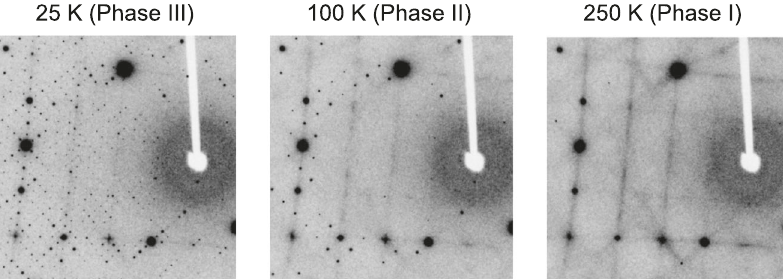
Fig. 4 Diffuse scatterings in the XRD patterns. Single crystal XRD patterns taken at 25 (Phase III), 100 (Phase II), and 250 K (Phase I) are shown. Diffuse scatterings are emphasized in these patterns. Since the intensity of diffuse scattering is much lower than those of Bragg re fl ections, the observed diffuse scattering has no effect on the crystal-structure re fi